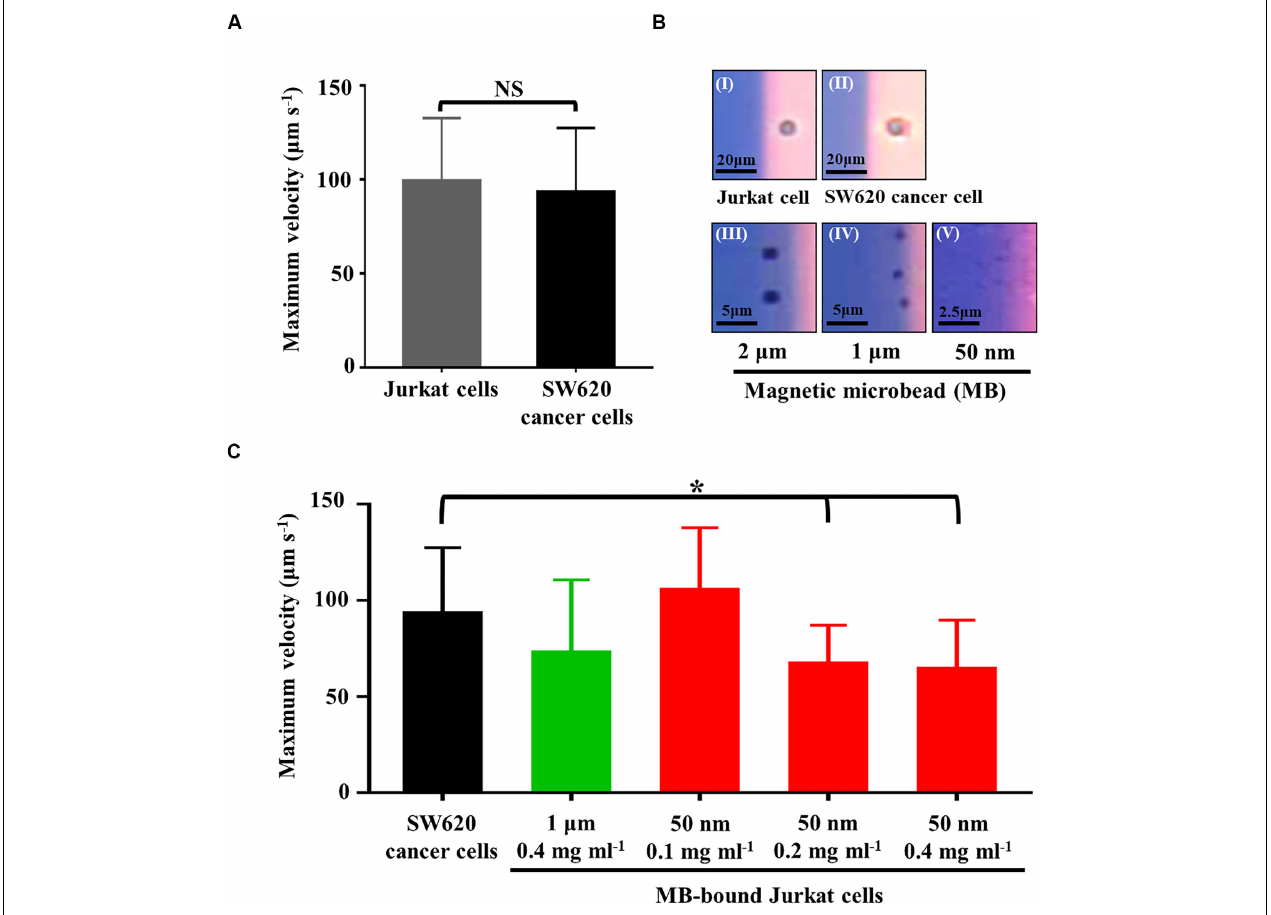
FIGURE 3 | (A) comparison of the maximum velocity of a moving light bar that can manipulate SW620 cancer cells and Jurkat cells, (B) the microscopic images showing the (I) Jurkat cell and (II) SW620 cancer cell were attracted within the light image, and the (III) 2 µ m, (IV) 1 µ m, and (V) 50 nm magnetic microbead (MB) were repulsed and thus located outside of the light image, (C) comparison of the maximum velocity of a moving light bar that can manipulate the SW620 cancer cells and the MB-bound Jurkat cells with different conditions as indicated [Data were presented as mean ± standard deviation ( n > 3). One-way ANOVA and the Tukey honestly significant difference (HSD) post hoc test were used for the statistical analysis. NS, No Significant difference ( p >0.05), ∗ Significant difference ( p